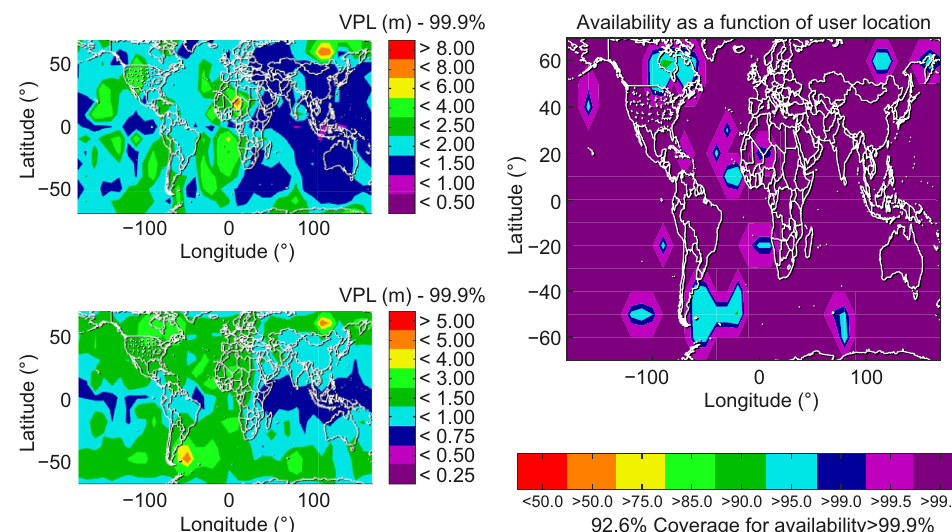
Fig. 4 PL (left) and Availability (right) for PPP-WAR model with regional corrections as a function of user location based on HAL